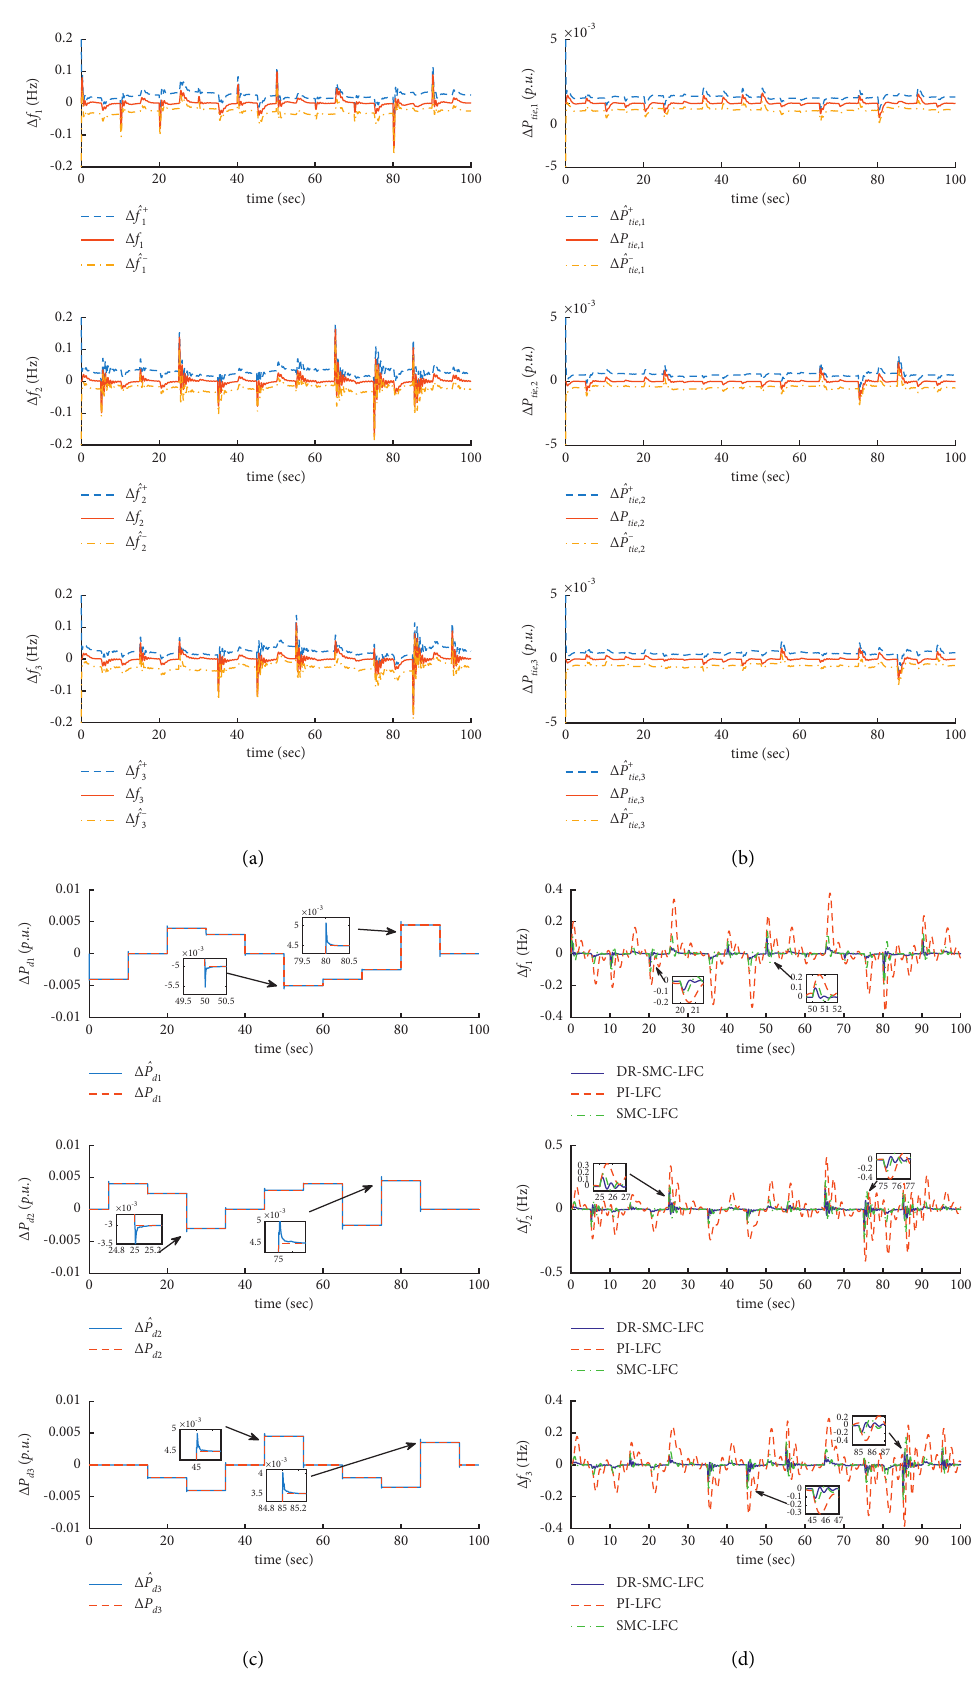
Figure 3: Simulation performance. (a) The interval estimation for Δ f power grid. (c) The reconstruction of the load disturbance Δ P di ( t ) of each power grid. (d) Δ f i ( t ) of each power grid under load